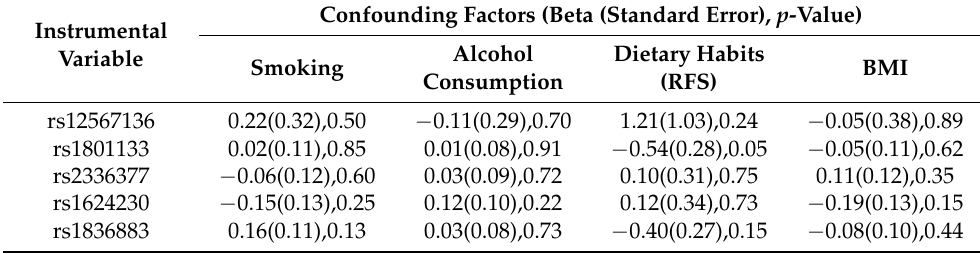
Table 4. The association between each instrumental variable and confounding